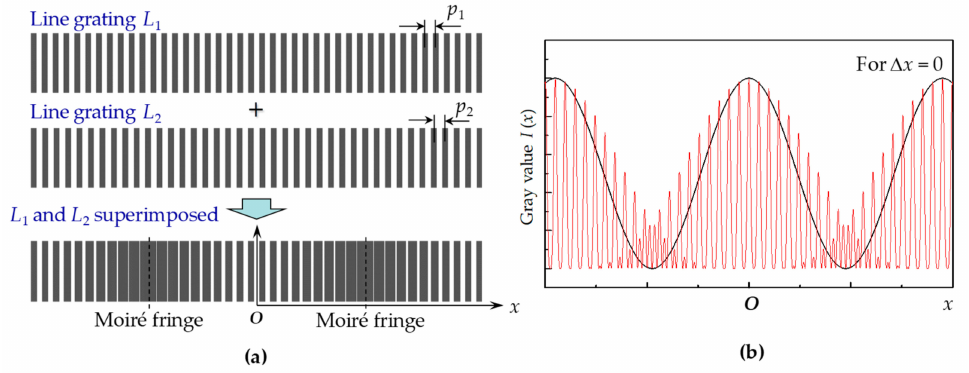
Figure 2. ( a ) Moir é fringes generated by the superimposing two line gratings ( L 1 and L 2 ) with slightly di ff erent pitches ( p 1 and p 2 ); ( b ) the intensity distribution (red line) of superimposed grating image along x -direction, from which a sinusoidal envelop curve (black line) can be derived to address the peaks of moir é fringes more clearly.